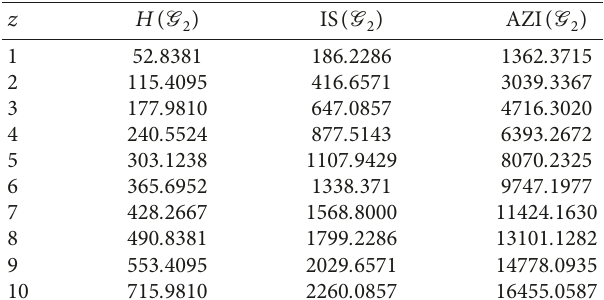
Table 10: Comparison among different indices of (TM-TCNB) 2 .